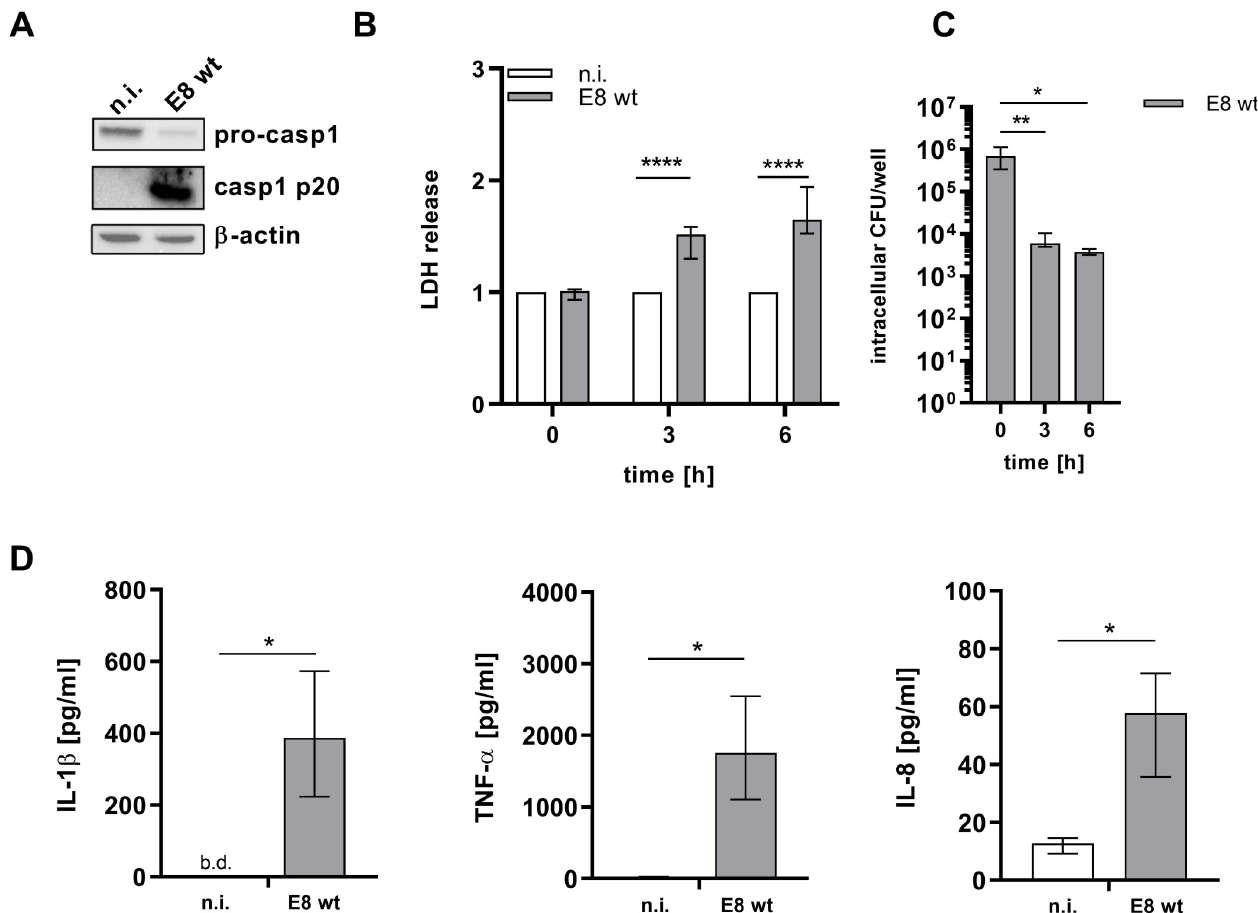
Fig 2. B . pseudomallei leads to inflammasome activation in hMDMs. hMDMs were infected with B . pseudomallei E8 (MOI 300) for 3 or 6h. (A) Immunoblot analysis was performed on lysates (3h p.i.) for full-length caspase-1 (pro-casp1) and cleaved caspase-1 (casp1 p20). Lysates were re-probed for β - actin. One representative experiment of three with different donors is shown. (B and C) Cell death and intracellular bacterial burden (in CFU/well) were determined at 0, 3 and 6h p.i. Shown are the results of at least 5 independent experiments with different donors performed in technical duplicates (median with interquartile range). (D) Cytokine release in supernatants was measured 3h p.i. Shown are the results of 4 independent experiments with different donors performed in technical duplicates. Data are represented as median with interquartile range. ( � p < 0.05, �� p < 0.01, ���� p < 0.0001). caspase-1 (pro- casp1), cleaved caspase-1 (casp1 p20), n.i. (not infected), wt (wild type), b.d. (below detection), hours (h), p.i. (post